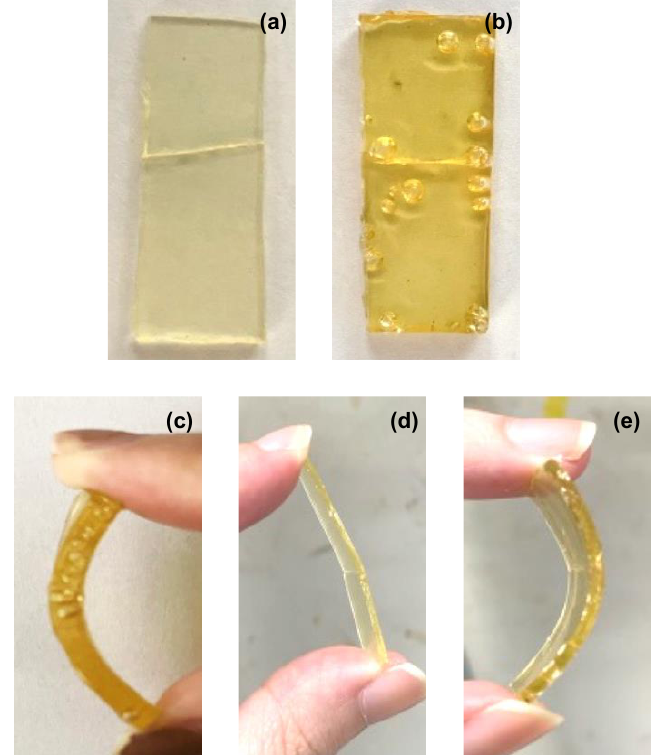
Figure 6. After 6 h self-healing features of ( a ) MDI-P1000, ( b ) TDI-P1000 and bending of ( c ) TDI-P1000 at room temperature, and ( d ) MDI-P1000, ( e ) TDI-P1000 at 80 °C.